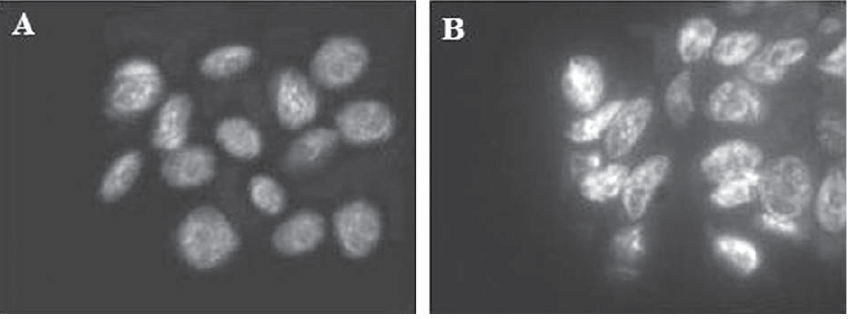
Fig. 2. Hybrydization in situ of CCND1 in tissue section of tumor specimens of older age group (B) shows the highest incidence of gene amplification than younger patients